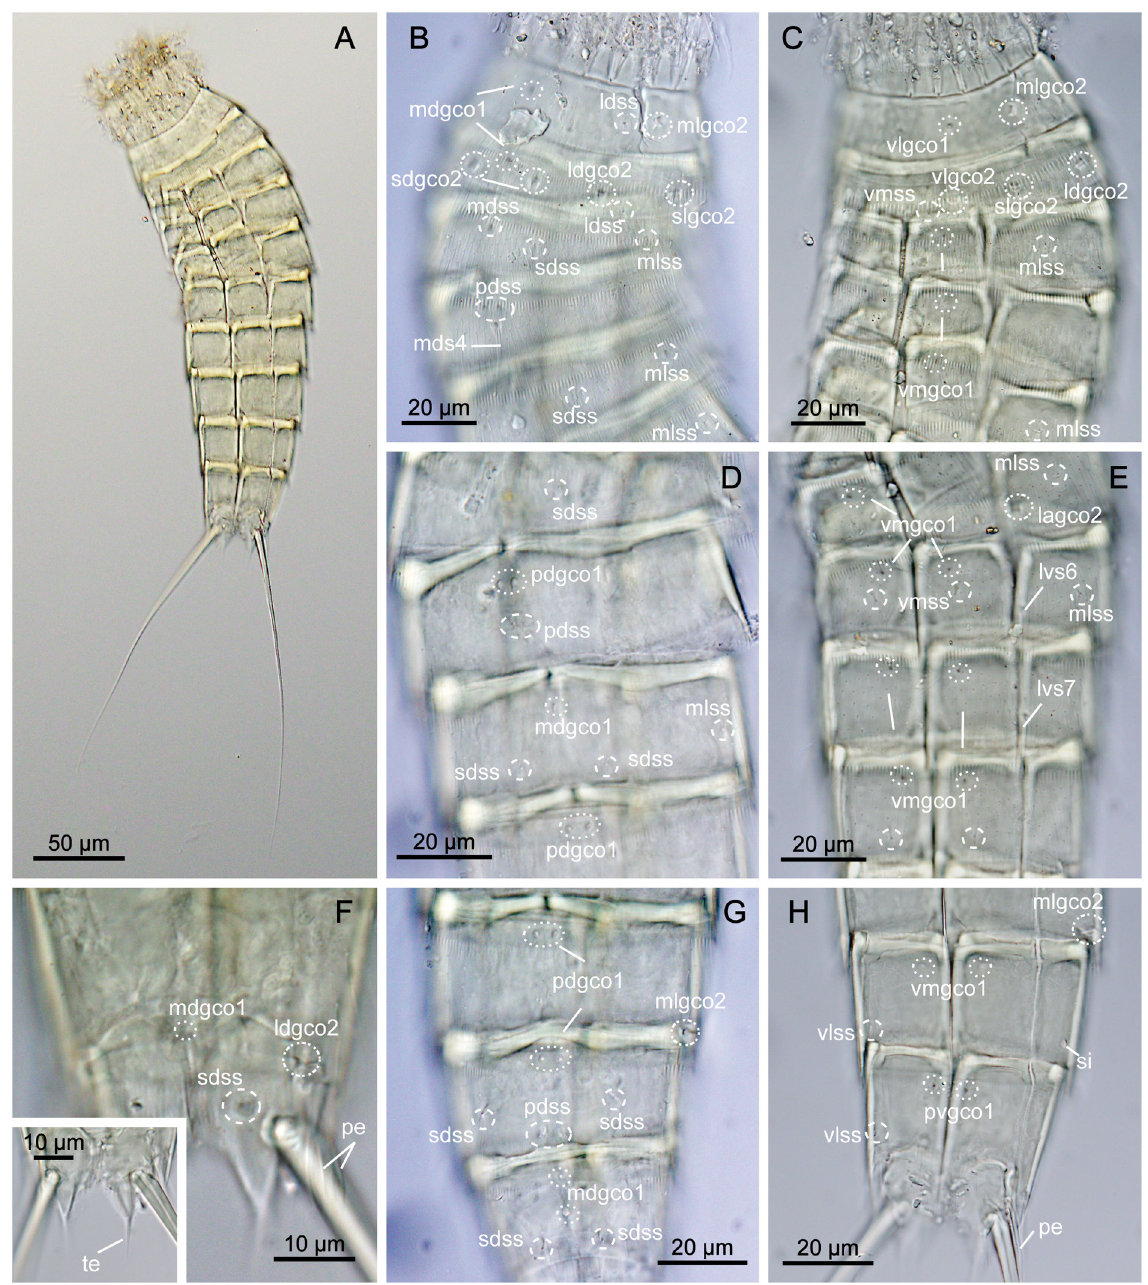
Fig. 36. Light micrographs showing overview and details of Echinoderes sp. aff. E. unispinosus , ♂ (NHMD-921792). A . Lateroventral overview. B . Segments 1 to 5, dorsolateral view. C . Segments 1 to 5, lateroventral view. D . Segments 5 to 8, dorsal view. E . Segments 5 to 8, lateroventral view. F . Segments 10 to 11, dorsal view, with inset showing close-up of tergal extensions of segment 11. G . Segments 8 to 10, dorsal view. H . Segments 8 to 11, lateroventral view. Abbreviations: see Material and